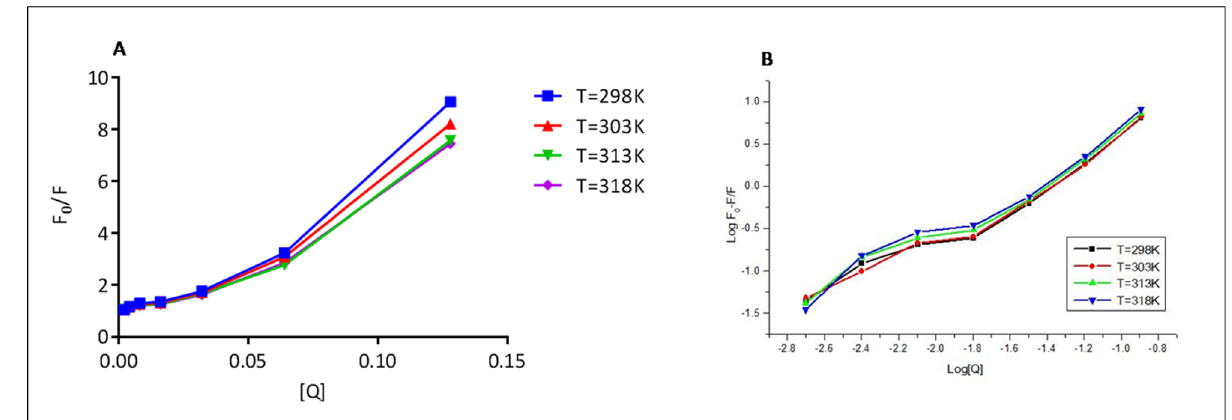
Figure 3. ( A ) Stern–Volmer plot of [F 0 /F] versus [Q] ( B ) Plot of Log [F 0 -F]/F versus Log [Q] at 298 K, 303 K, 308 K, 318 K.